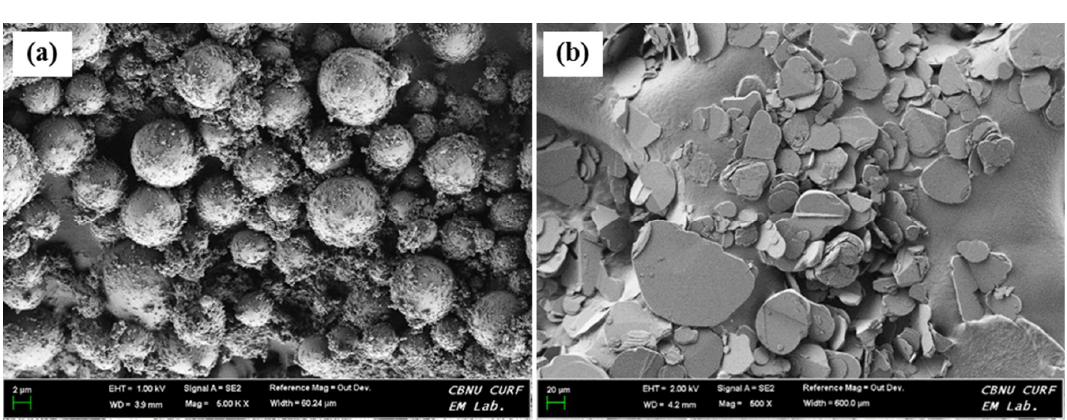
Figure 1. SEM images of alumina ( a ) and crystalline boron nitride ( b ) investigated in this study.